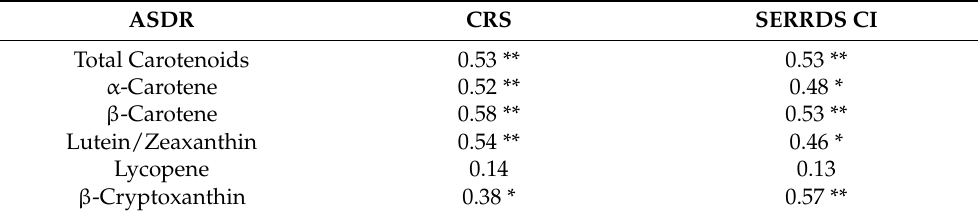
Table 4. Correlations between single dietary carotenoids assessed using app-based short dietary record in weeks 1–4 and weeks 5–8 with skin levels from week 4 and week 8 ( n = 42).